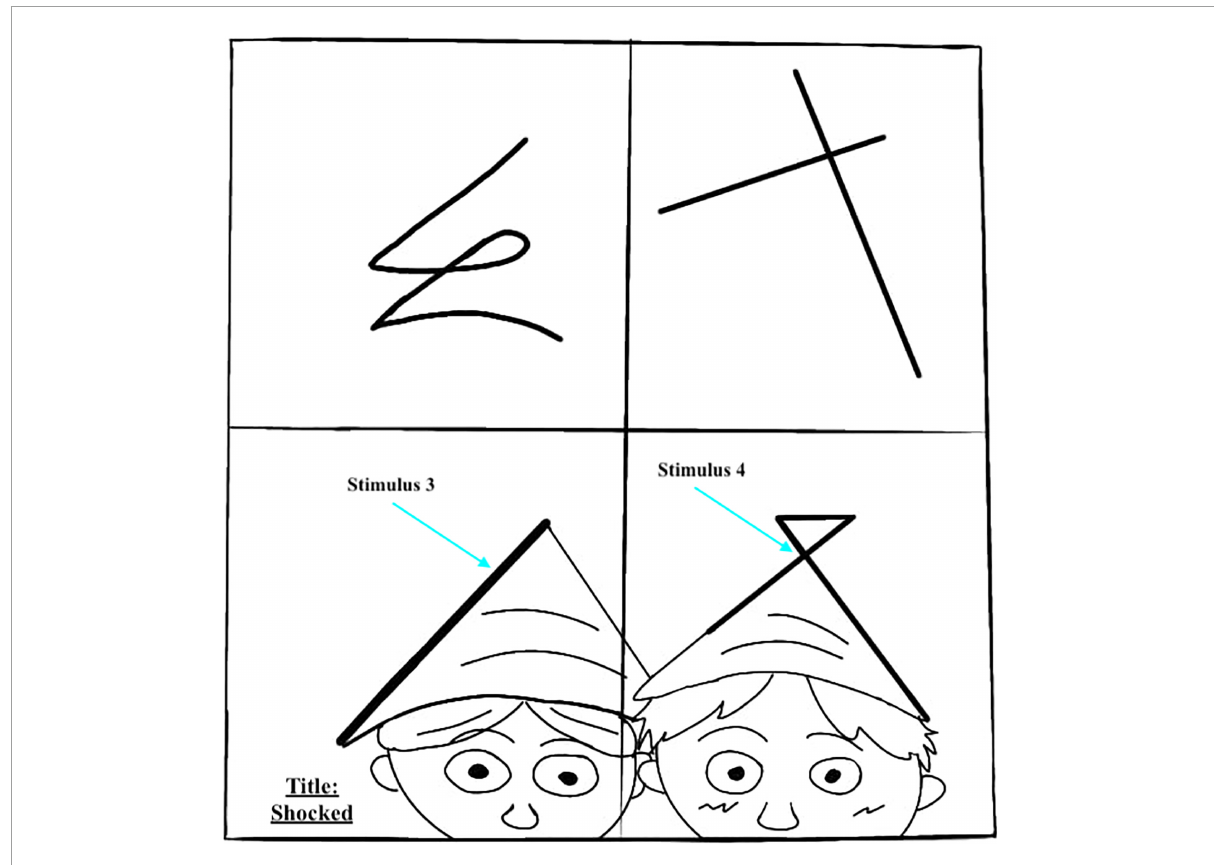
FIGURE2 Example of combining two incomplete